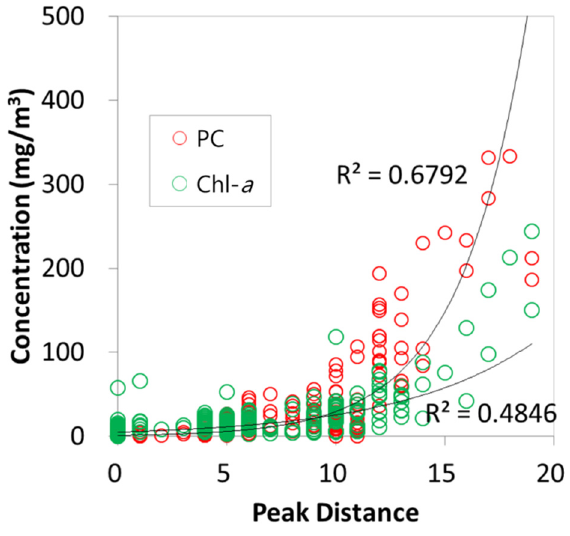
Figure 4. Relationship between the near 700 nm peak shift ( ∆ λ peak ), and phycocyanin or chlorophyll- a concentration.